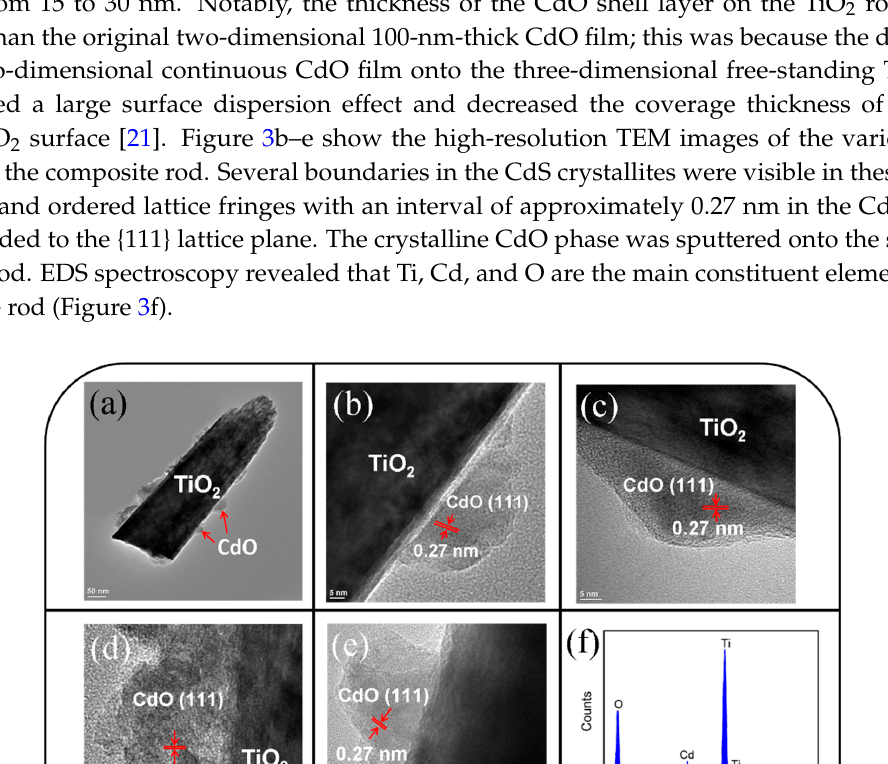
Figure 3. TEM analyses of the TiO 2 –CdO composite rod: ( a ) Low-magnification TEM image of the TiO 2 –CdO rod; ( b – e ) HRTEM images taken from the local regions of the rod; ( f ) EDS spectra of Ti, Cd, and O elements taken from the rod.